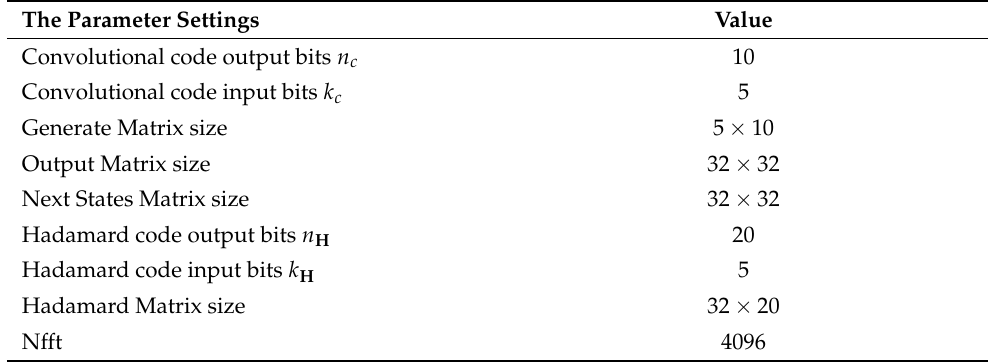
Table 2. The parameter settings of the convolutional code and the Hadamard code.